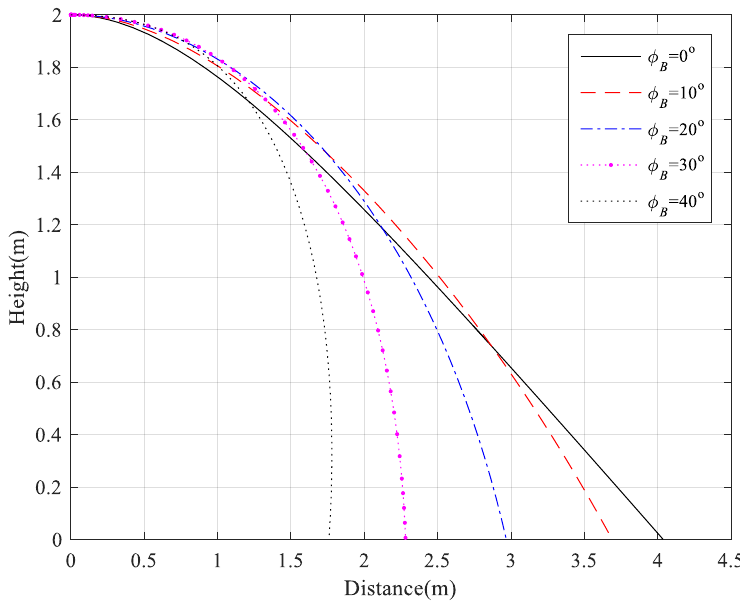
Figure 18. Simulation results for gliding trajectory.